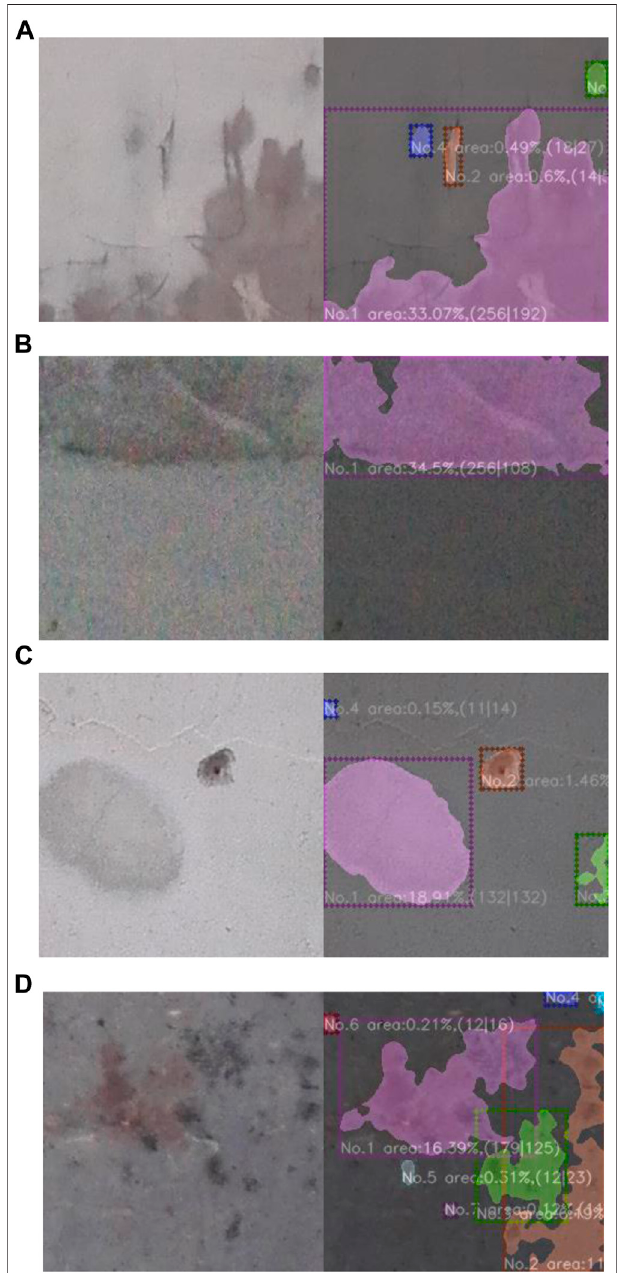
FIGURE 15 | Quanti fi cation results of different FFC chromatic aberration defect categories: (A) Light color incomplete chromatic aberration input and output (B) Dark color incomplete chromatic aberration input and output (C) Light color complete chromatic aberration input and output (D) Dark color complete chromatic aberration input and